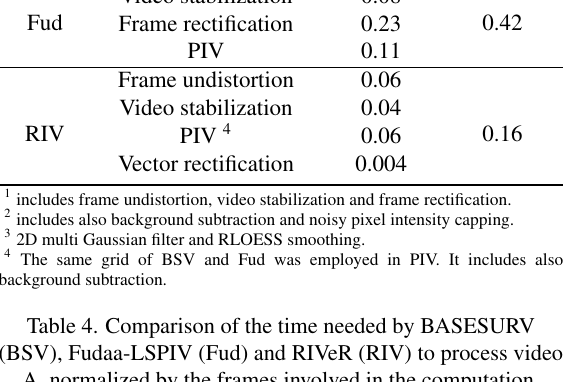
Table 4. Comparison of the time needed by